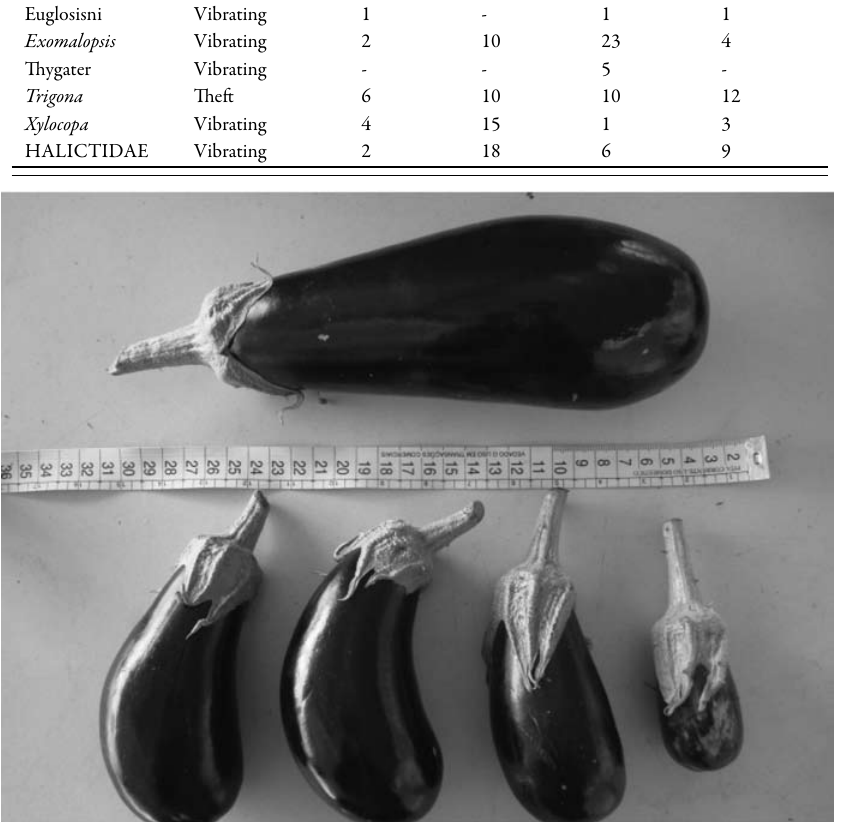
Fig.1. Top: Fruit produced from T2 test (free insect visitation); Bottom: fruits produced from bagged flowers